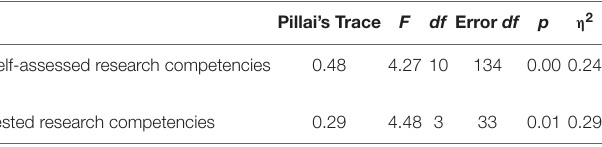
F = F-statistic; df = degrees of freedom; p = level of significance; η 2 = effect size. TABLE 3 | Univariate effects for self-assessed and tested research competencies. df